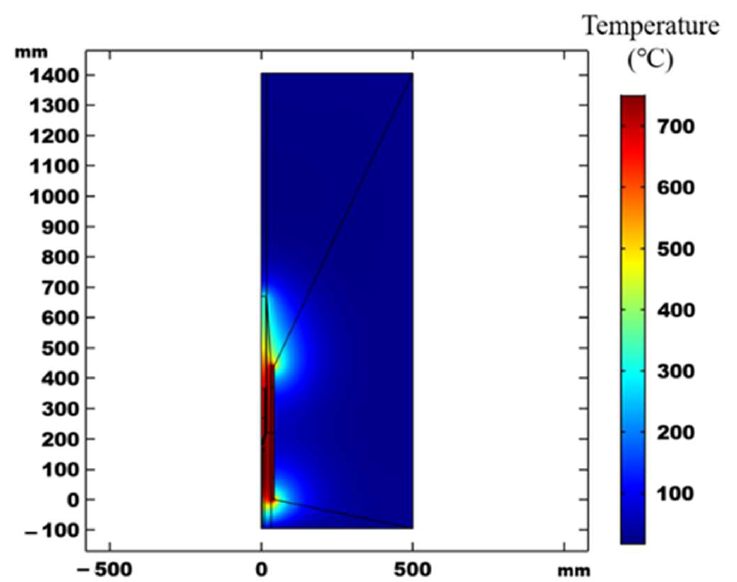
Figure 6. Schematic diagram of temperature field at heat preservation thermal equilibrium. Heat is transferred through furnace-air-reactor-hydrogen-crucible-(hydrogen)-LiH in heating. The LiH temperature at the cone point (contact point between LiH and